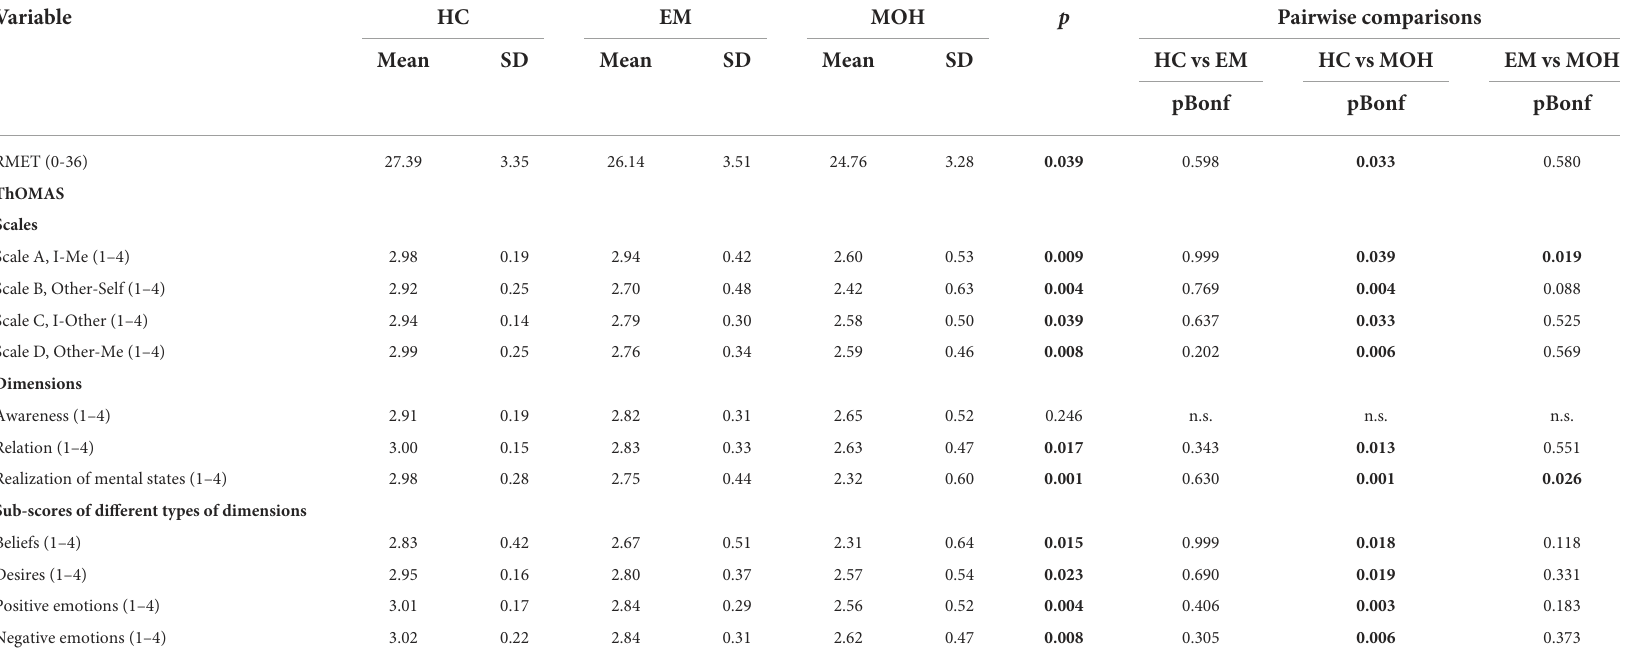
TABLE 2 Performances of HC, EM, and MOH groups in ToM tasks compared with nonparametric Kruskal–Wallis ANOVA.